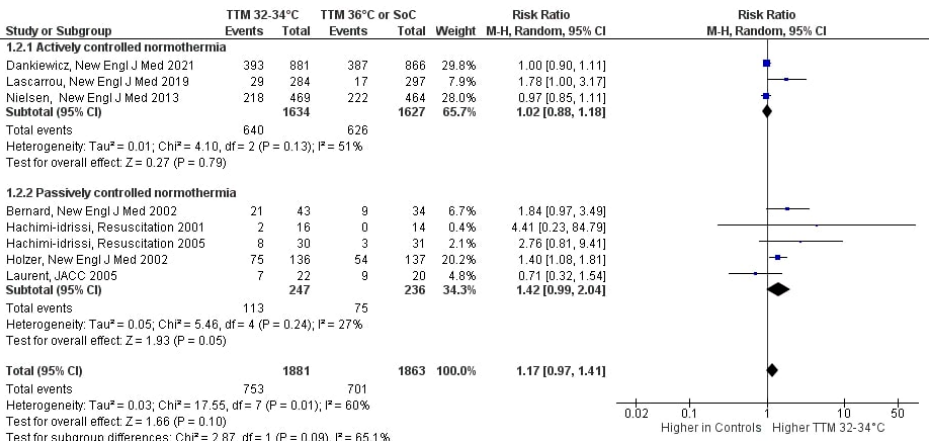
Figure 3. Forest plot of neurological outcome in patients resuscitated after cardiac arrest. Comparison is made between patients according to the strategy of target temperature management (TTM). CI: confidence interval, M-H: Mantel-Haenszel.